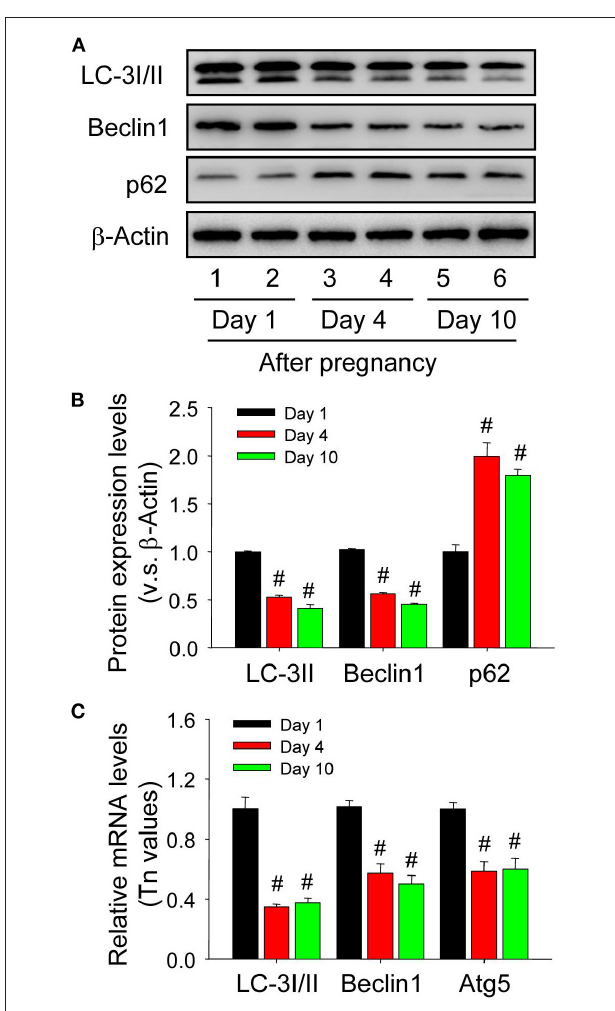
FIGURE 8 | Expression changes of autophagy-related proteins in the luteal cells during the development of corpus luteum. (A) Expression changes of LC-3I/II, beclin1, and p62 proteins in luteal cells during the development of corpus luteum (from Day 1 to 10). (B) Summarized intensities of LC-3I/II, beclin1, and p62 bloting normalized to the control (Day 1). (C) Expression Changes of LC-3I/II, beclin1, and Atg5 mRNA in the luteal cells during the development of corpus luteum. The luteal cells were obtained from the pregnant corpus luteum on Day 1, 4, and 10. Each value represents the mean ± SE. One-way analysis of variance (ANOVA) was used to analyze the data, followed by a Tukey’s multiple range test. n = 6. # P < 0.05, vs. the group in